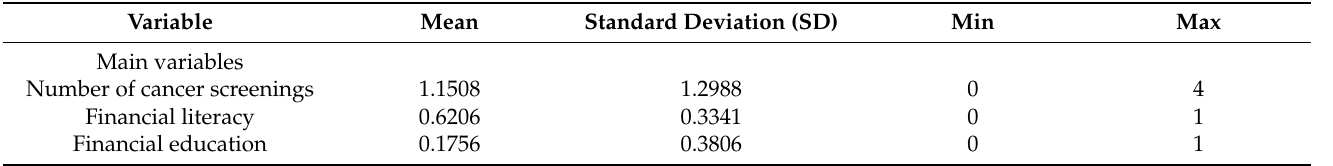
Table 2. Descriptive